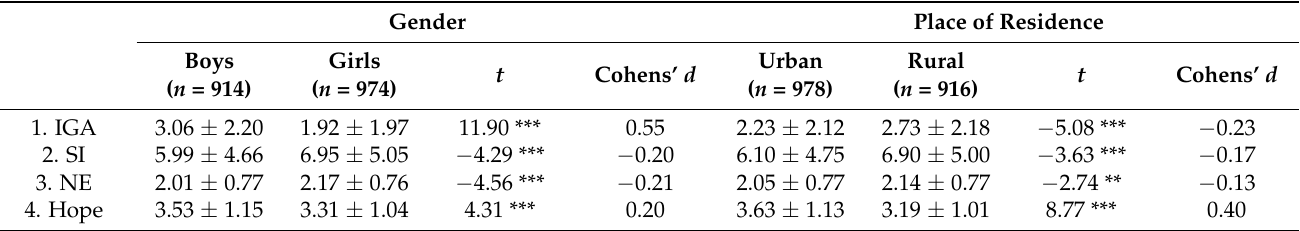
Table 1. Differences in the main variables by gender and residence ( M ± SD ). Gender Place of Residence